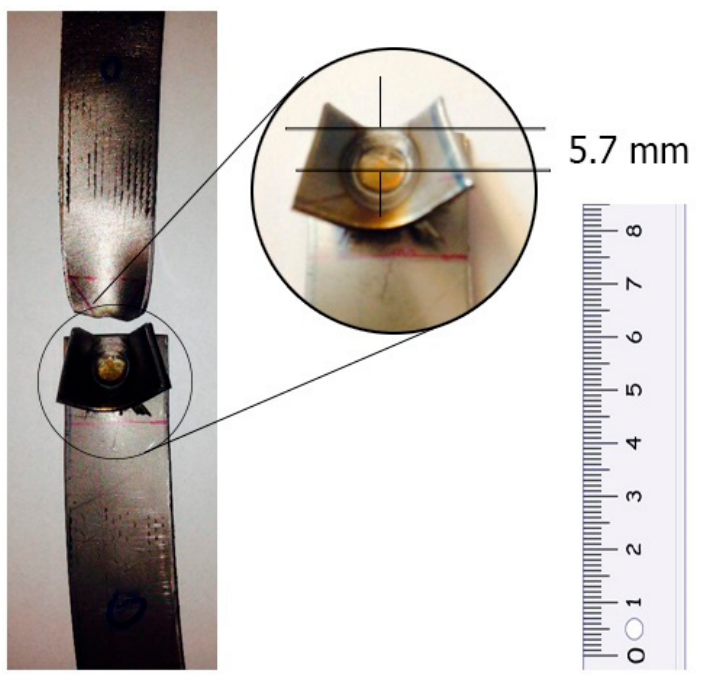
Figure 15. Fractured RSW sample during shear tensile test, 2500 A, 1 s.